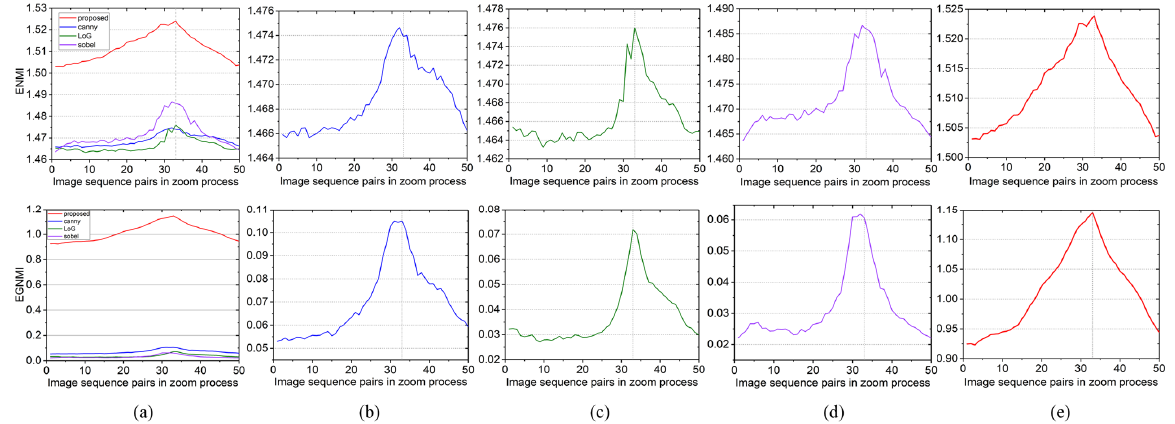
Figure 7. Evaluation function curves based on di ff erent edge algorithms: ( a ) overall; ( b ) canny; ( c ) LoG; ( d ) Sobel; and ( e ) proposed.